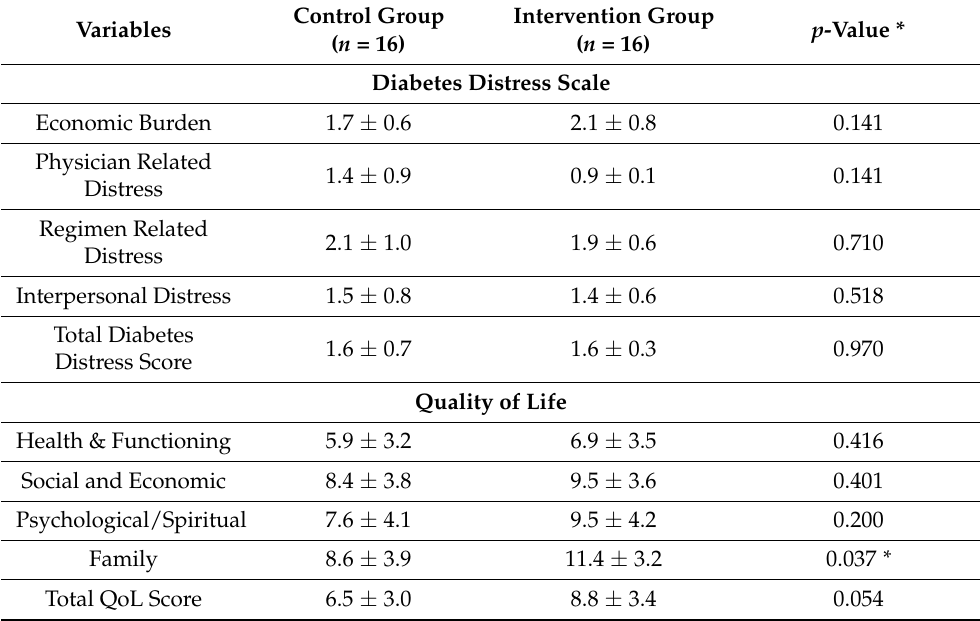
Table 2. Comparison of the quality of life (QoL) and Diabetes Distress Scale (DDS) score among the control and intervention groups at the baseline.